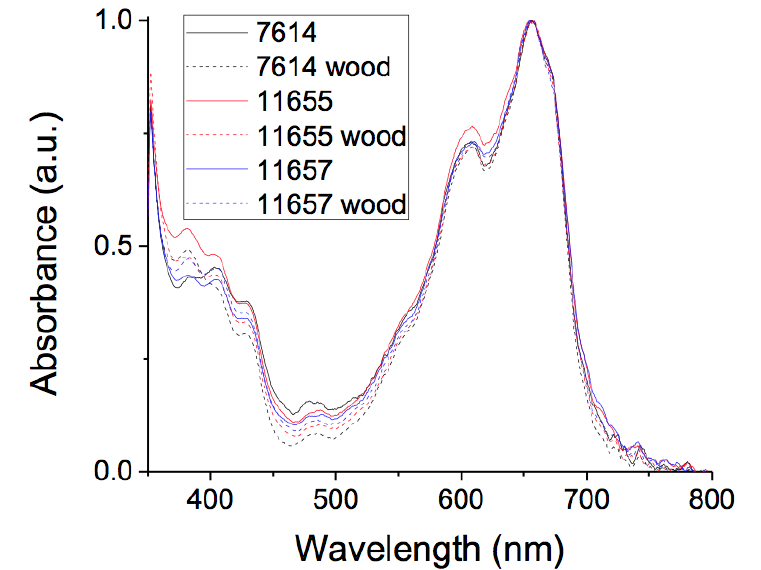
Figure 8. Xylindein absorption across growth strains and growth conditions for week 9 samples. Chlorociboria cultures ( C. aeruginosa strain UAMH 11657 and C. aeruginascens strains UAMH 11655 and UAMH 7614) grown in lab-grade malt media, in either liquid culture or woodchip-amended agar plates (denoted “wood” in legend). Absorbance of extracted pigment solutions showed a characteristic xylindein peak at ≈ 660 nm and variation in absorbance at shorter wavelengths. Averages are given for each strain; however, a large amount of variability was seen between samples of each strain around the 400 nm mark. Therefore, no strain could be clearly identified as producing highest quality pigment using optical